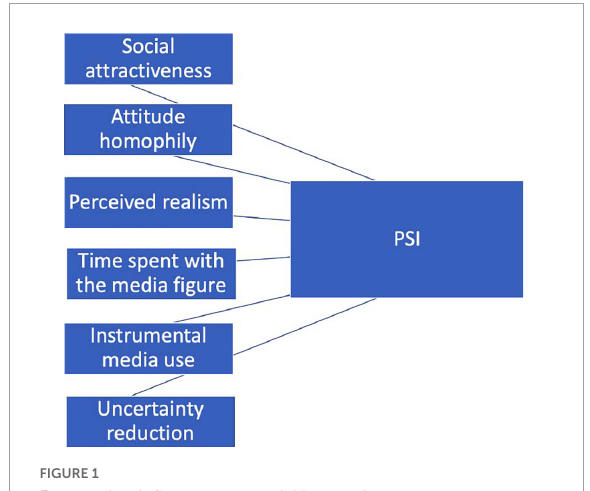
FIGURE1 Factors that influence parasocial